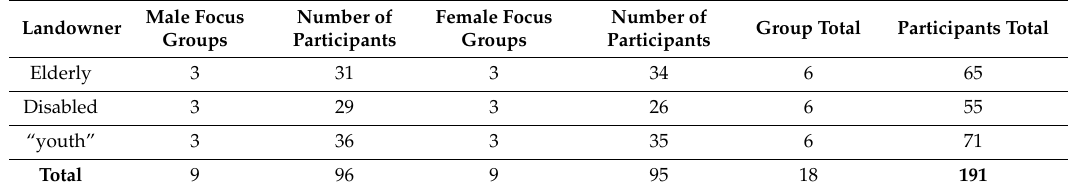
Table 1. Landowner FGD participants in Sing, Piina number 1 and Nimoro.